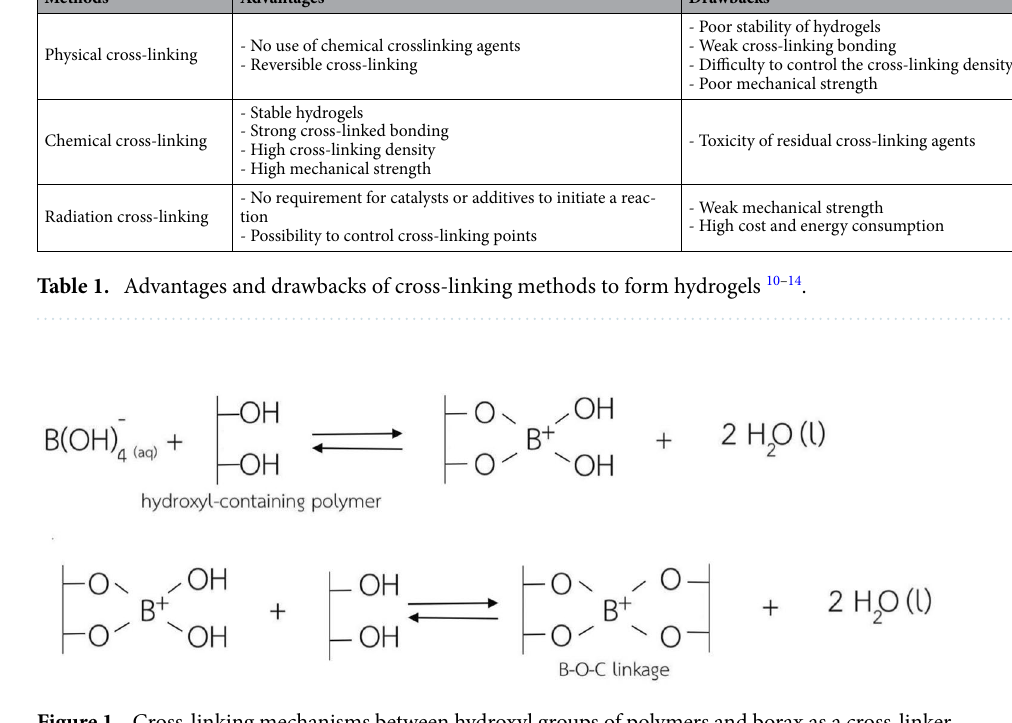
Figure 1. Cross-linking mechanisms between hydroxyl groups of polymers and borax as a